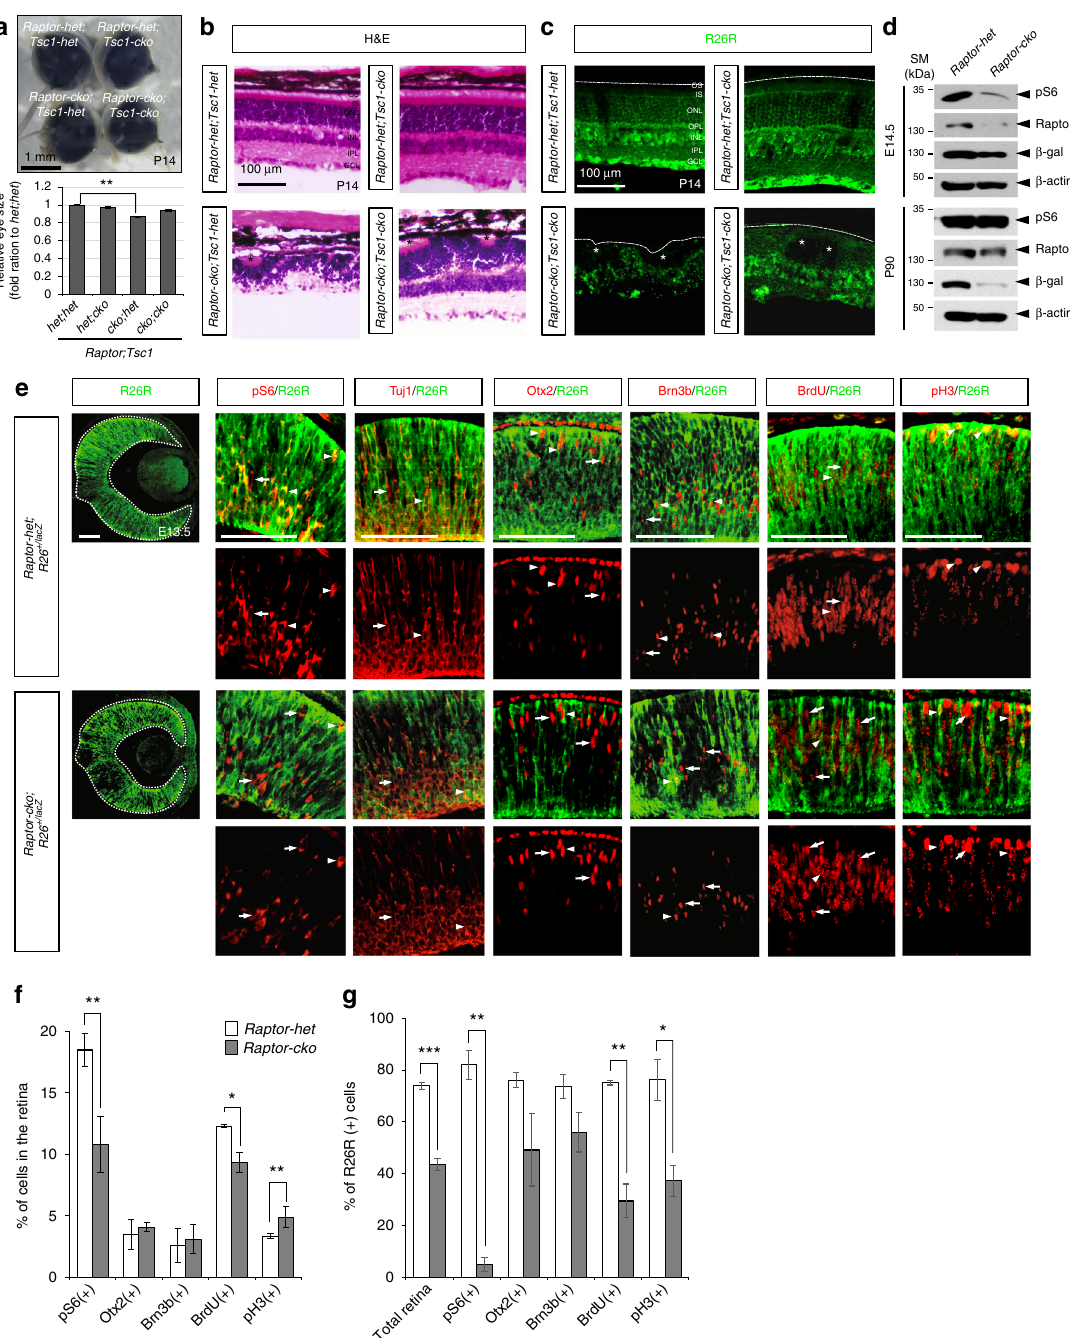
Fig. 4 Raptor -de fi cient RPC fails to progress cell cycle. a Top, images of P30 Raptor-het;Tsc1-dhet , Raptor-het;Tsc1-cko , Raptor-cko;Tsc1-het , and Raptor-cko; Tsc1-cko littermate mouse eyes. Bottom, relative eye sizes are shown in a graph by comparing average diameter of the eyes. Number of eyes measured the size is 8 ( Raptor-het;Tsc1-het and Raptor-het;Tsc1-cKO ), 6 ( Raptor-cko;Tsc1-het ), and 5 ( Raptor-cko;Tsc1-cko ). ** P -value < 0.01 (ANOVA test). b H&E staining images of P14 Raptor-het;Tsc1-het , Raptor-het;Tsc1-cko , Raptor-cko;Tsc1-het , and Raptor-cko;Tsc1-cko littermate mouse retinal sections. c Distribution of Raptor - de fi cient cells in P14 littermate mouse retina was visualized indirectly by immunodetection of R26R, which is expressed from Cre-recombined R26 lacZ loci. d Levels of pS6, Raptor, and R26R (ß-gal) in E14.5 and P90 Raptor-het and Raptor-cko littermate mouse retinas were compared by WB with corresponding antibodies. Relative amounts of protein loaded in each lane were determined by WB detection of ß-actin. e Distributions of retinal markers in E13.5 Raptor- het;R26R + /lacZ and Raptor-cko;R26R + /lacZ littermate mouse embryonic retinas were examined by immunostaining with corresponding antibodies. The R26R- positive cells (green) are potentially the Raptor -de fi cient cells. BrdU was injected to pregnant mice at 3 h prior to embryo collection. Arrows and arrowheads indicate R26R-negative and R26R-positive cells that express speci fi c markers (red), respectively. Scale bar, 100 μ m. f Percentage of retinal cells expressing each marker in the retinas was provided in a graph (representative images are shown in Supplementary Fig. 7). g Ratios of R26R co-expressing cells to total marker-expressing cells in a are shown in a graph. Numbers of samples used for obtaining graphs in b and c are 4 (from 3 independent litters); error bars denote SD. P -values are obtained by Student ’ s t -test and shown in the graphs (*<0.05; **<0.01; ***<0.001)